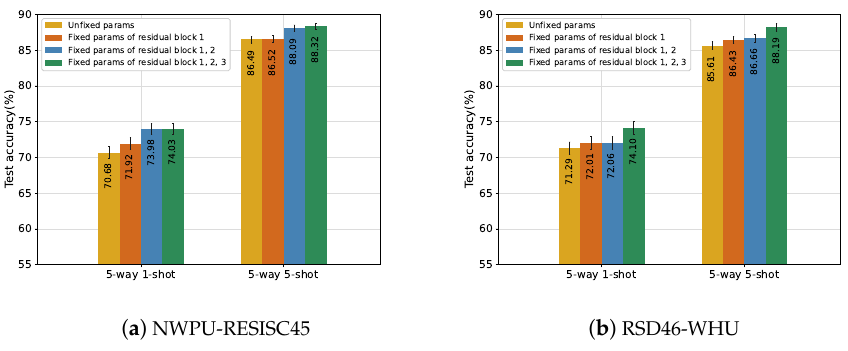
Figure 6. Influence of different fine-tuning strategies.